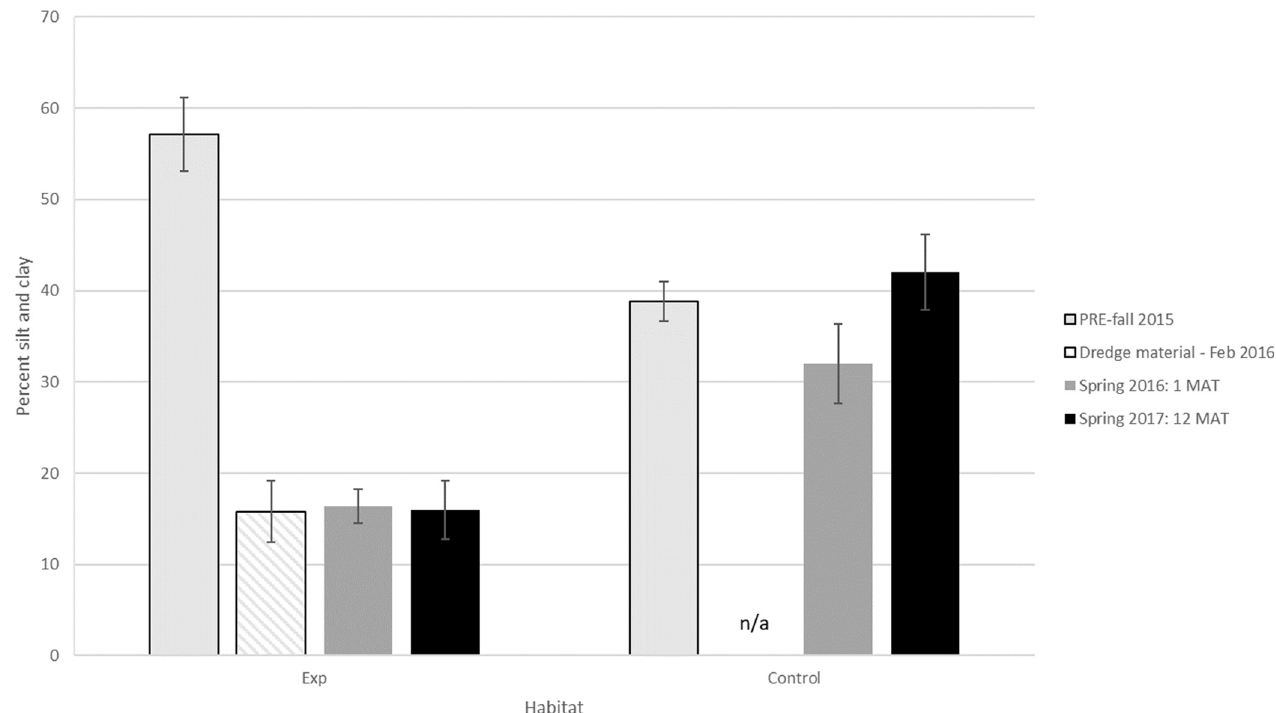
Fig 3. Percent silt and clay in sediment cores collected through time from the control and experimental sites at SBNWR to document key changes. Data are presented from before sediment application (PRE-fall), during sediment application (February 2016) and after sediment application (1 MAT, 12